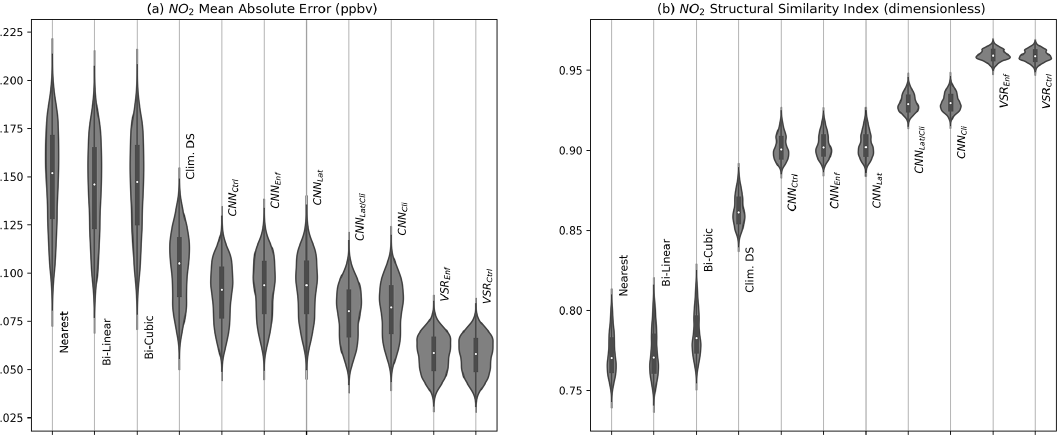
Figure 5. Distribution of mean absolute error and SSIM with respect to individual test cases for NO 2